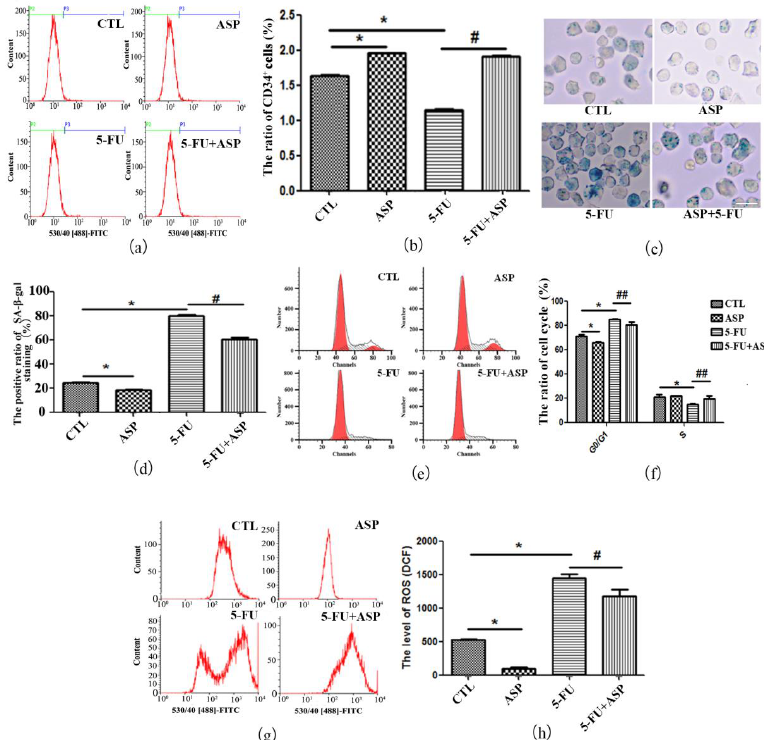
Figure 6. ASP-treated HS-5 feeder layer protects co-cultured hematopoietic cells from oxidative stress-induced premature senescence. ( a ) Survival CD34 + HSPCs co-cultured on HS-5 stromal cell feeder layers were examined via flow cytometry. The green line represents CD34 − cells and the purple line represents CD34 + cells; ( b ) The percentage of co-cultured CD34 + HSPCs in human umbilical cord blood-derived hematopoietic cells is presented as means ± SD; ( c ) The senescent hematopoietic cells were positively stained by SA- β -gal to be blue-green. Co-cultured on the 5-FU-treated feeder layer, the frequency of SA- β -gal positive hematopoietic cells increased. However, co-cultured on the ASP-treated feeder layer, the number of senescent hematopoietic cells reduced (Scale bar = 50 µ m); ( d ) The percentage of SA- β -gal positive co-cultured hematopoietic cells is presented as means ± SD; ( e ) Representative flow cytometry graphs of cell cycle analysis of co-cultured hematopoietic cells; ( f ) Results of cell cycle distribution of co-cultured hematopoietic cells are presented as means ± SD; ( g ) Levels of ROS in co-cultured hematopoietic cells were measured by DCF-DA staining and flow cytometry; ( h ) Mean fluorescence of ROS was quantified and is presented as means ± SD. * p < 0.01 vs. control group, # p < 0.05 vs. 5-FU group, ## p < 0.01 vs. 5-FU